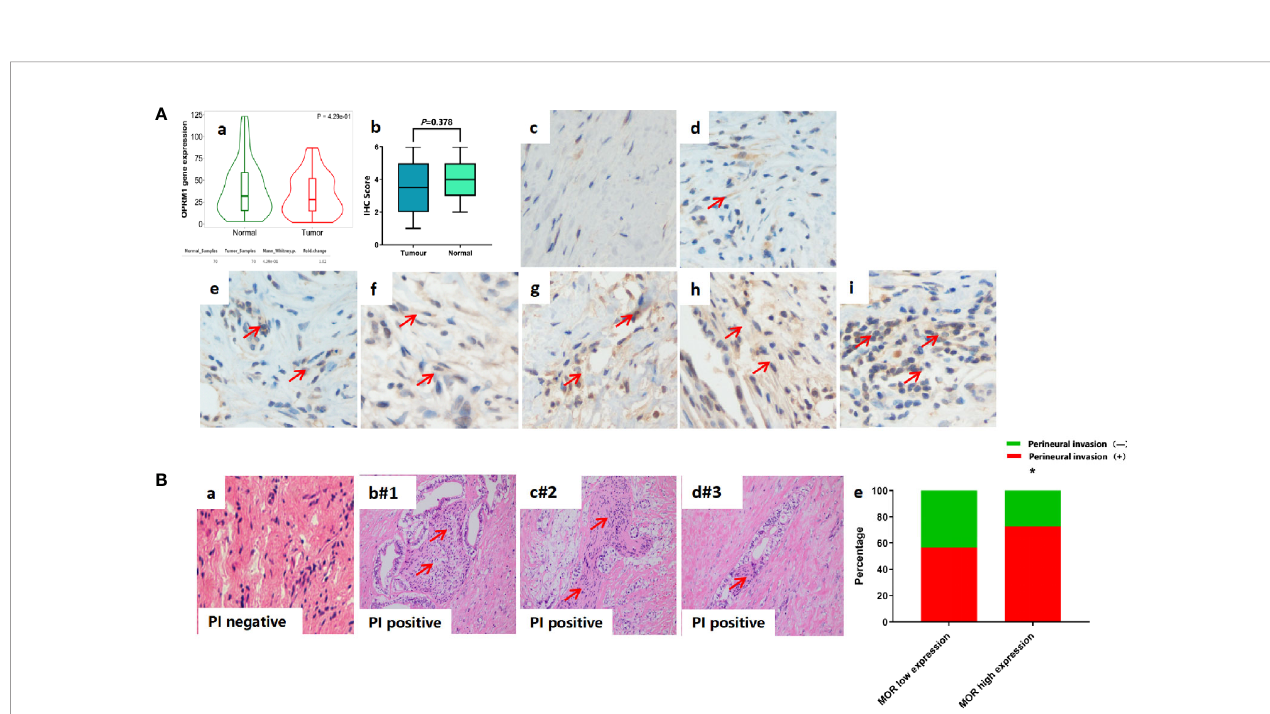
FIGURE 2 | (A) Representative image of IHC sample to describe scoring and MOR expression. All images are magnitude 400. (a) OPRM1 gene expression in PDAC tumour tissue and adjacent non-tumour tissue; (b) MOR expression in PDAC tumour tissue and adjacent non-tumour tissue; (c) score 0; (d) score 1; (e) score 2; (f) score 3; (g) score 4; (h) score 5; (i) score 6. (B) Representative image of HE staining sample to describe Perineural invasion (PI). (a) PI negative. (b-d) PI positive patients (#1-3). (e) PI positive according to MOR expression. *P < 0.001.